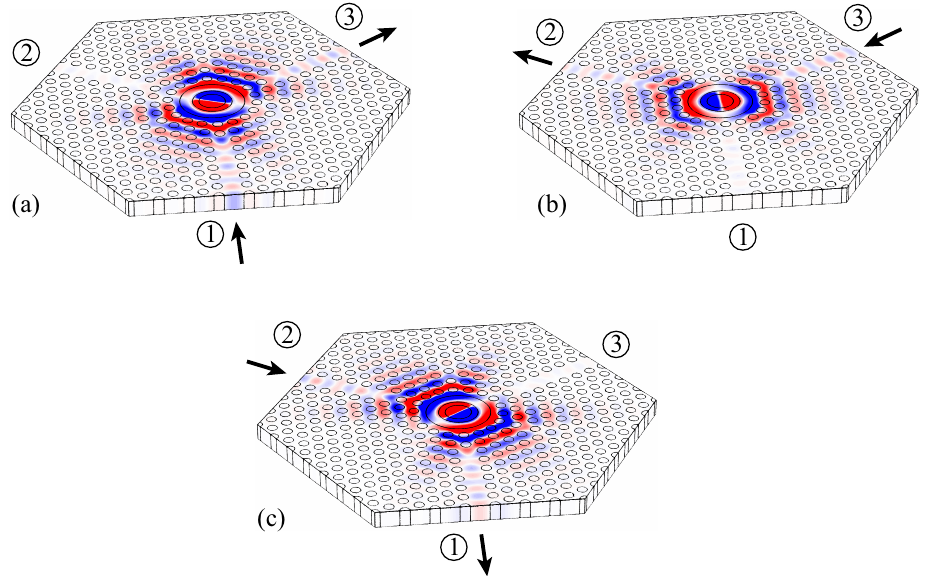
Figure 9. H z distribution at the center frequency f 0 obtained from 3D simulations performed with COMSOL Multiphysics for excitation at ( a ) port 1, ( b ) port 3, and ( c ) port 2. At the center frequency f 0 = 193.3978 THz (equivalently, λ 0 = 1550.134 nm), the insertion loss is − 1 dB, while the isolation and reflection levels are − 15 dB and − 24 dB, respectively. The frequency band of the circulator (highlighted in yellow in Figure 8) is defined by the lower and upper limits f 1 = 193.3953 THz and f 2 = 193.4003